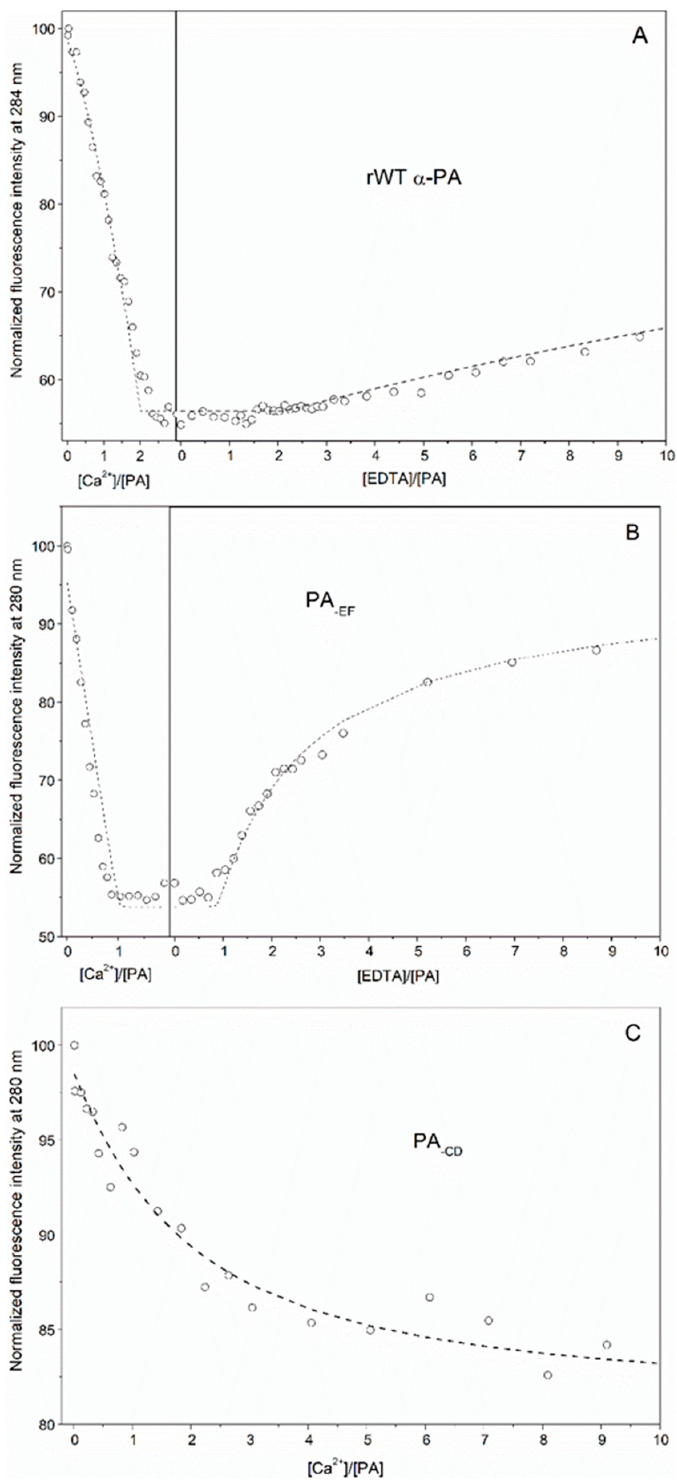
Figure 1. Spectrofluorimetric titrations of rWT α -PA ( A ) and its mutant forms, PA -EF ( B ) and PA -CD ( C ) via Ca 2+ /EDTA at 20 °C (10 mM HEPES-KOH, pH 8.1). Protein concentration is 12–17 µM. Fluorescence was excited at 259 nm. The points are experimental. ( A ) The curve is fit according to the sequential metal binding scheme (1), considering a competition between the protein and EDTA for Ca 2+ (scheme (2)). ( B , C ) The curve is a fit within the single site metal binding scheme (3). The competition between the protein and EDTA for Ca 2+ is taken into account for PA -EF